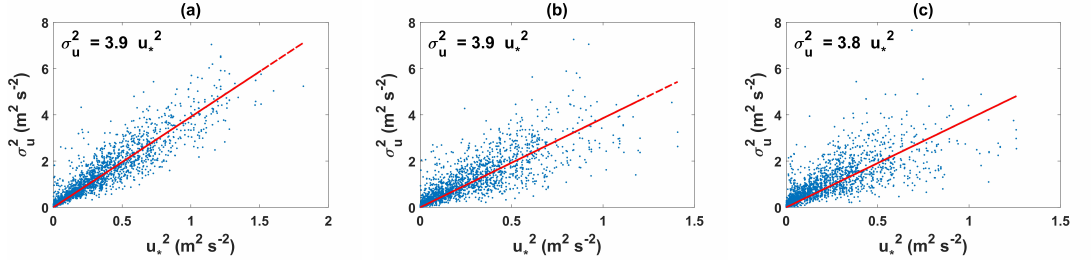
Figure 17. The linear relation between σ 2 u and u ∗ 2 while setting the intercept to the origin, and for the sonic anemometers on ( a ) boom 4 (32 m), ( b ) boom 5 (80 m), and ( c ) boom 6 (106 m).